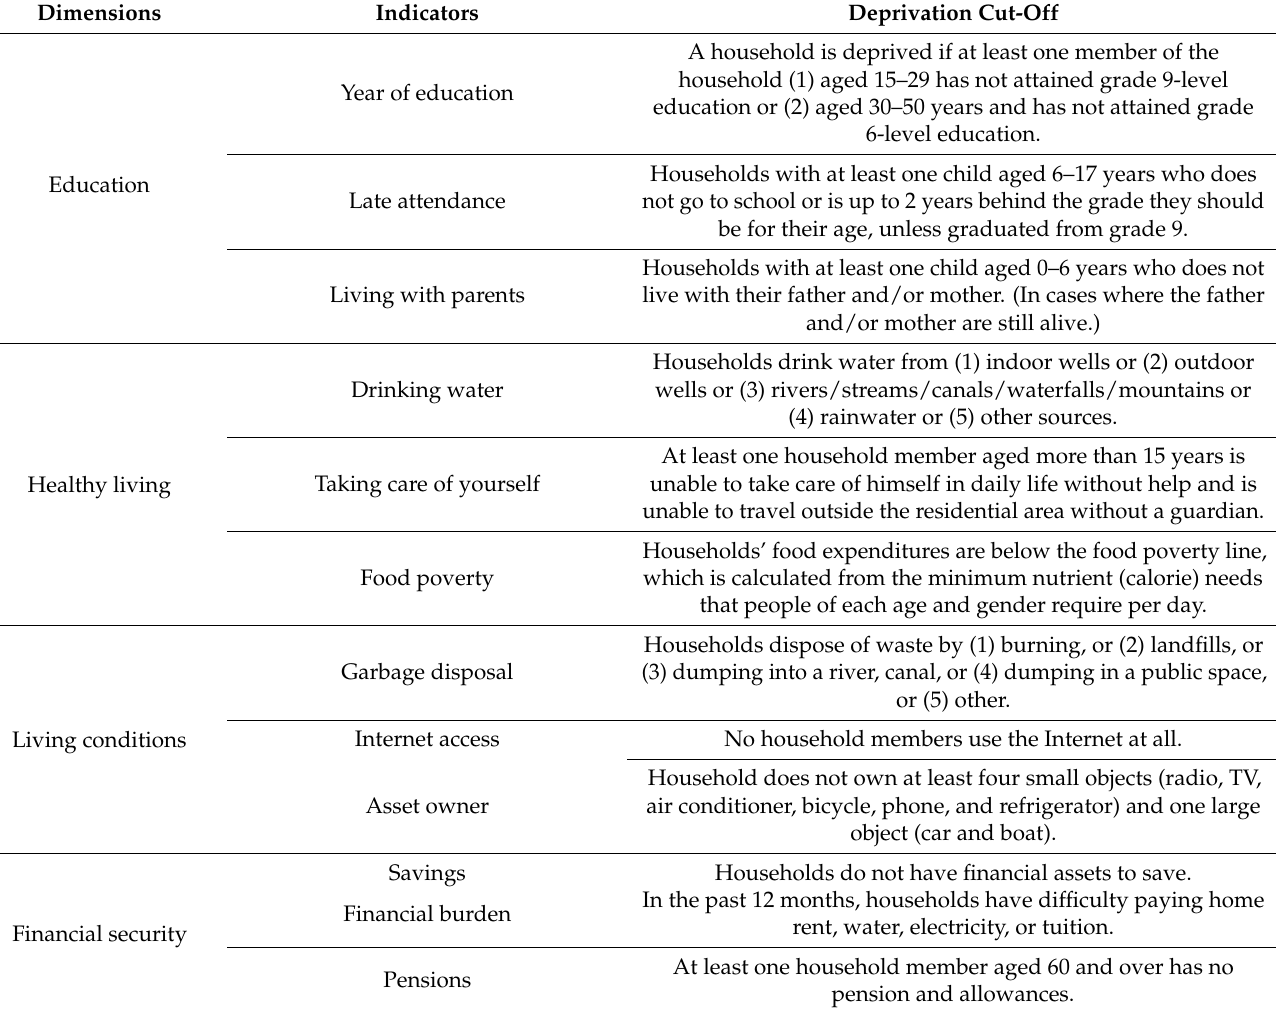
Table 2. List of indicators included in MPI